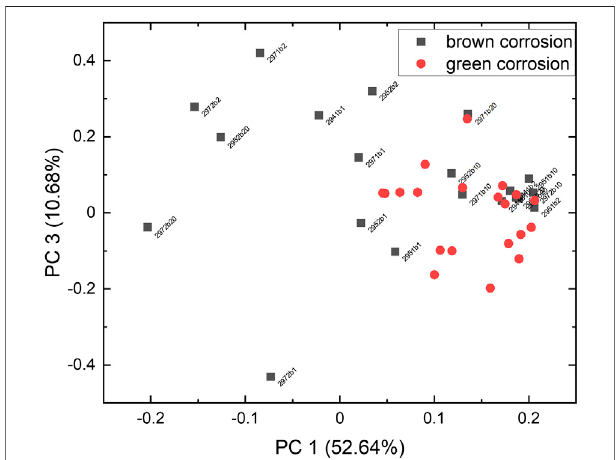
FIGURE 8 | PCA loadings plot of PC1 vs. PC3.